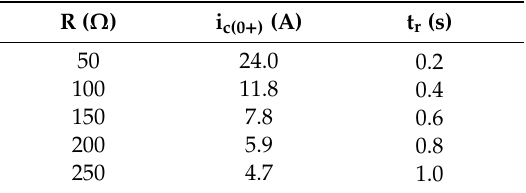
Table 3. Relationship between i c(0 + ) , t r (s) and R e